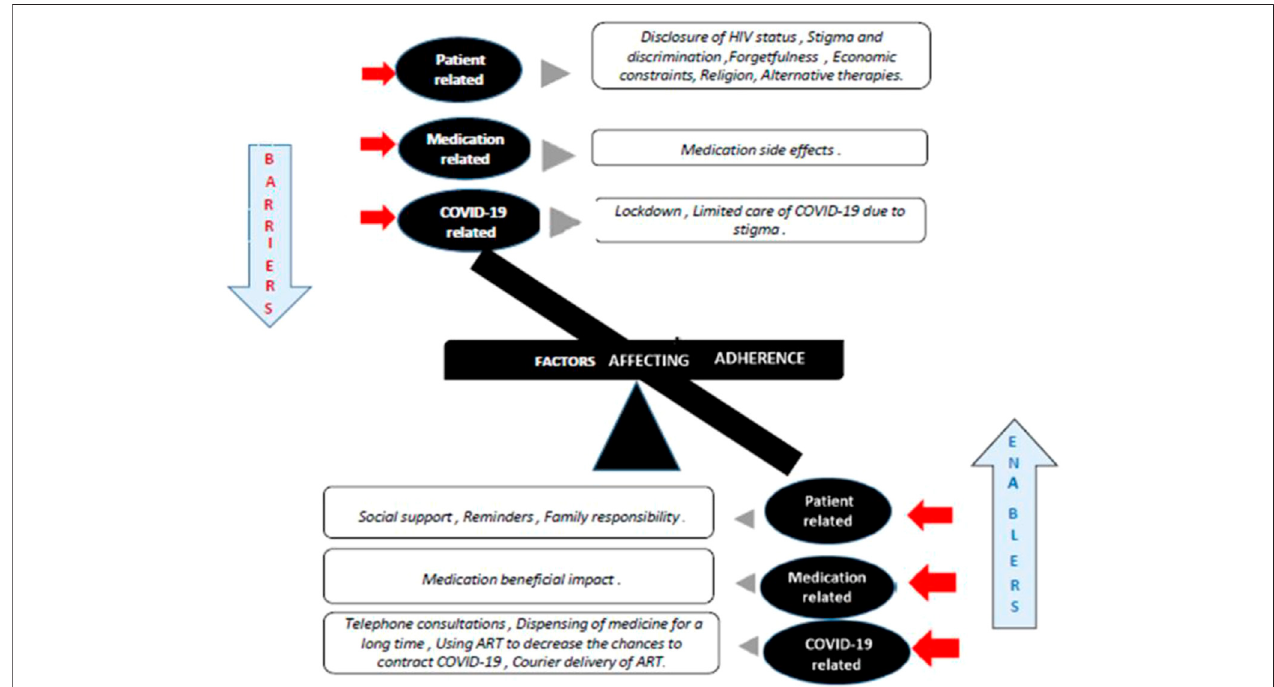
FIGURE 1 | Barriers and enablers of adherence to ART identi fi